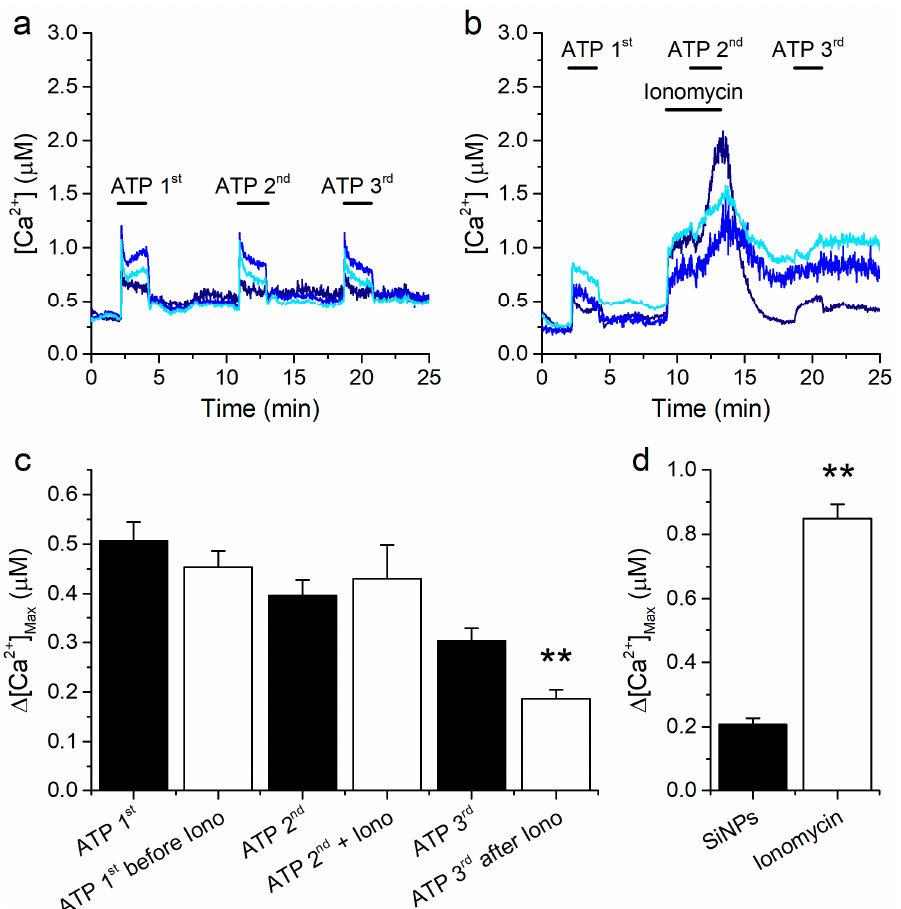
Figure 6. Response to ATP in 16HBE cells overloaded with Ca 2+ . ( a ) Example of control [Ca 2+ ] traces recorded in 16HBE cells showing the responses to repetitive extracellular application of 10 µ M ATP. ( b ) Examples of traces showing the effects of 1 μ M ionomycin when applied before and during the second application of 10 μ M ATP. ( c ) Amplitude of the responses to three consecutive applications of ATP for the control series of experiments (black bars, n = 36) and for a series of experiments in which 1 μ M ionomycin was applied 2 min before and during the second application of ATP (white bars, n = 42). The data are represented as mean ± s.e.m. The asterisks denote statistically significant difference between ATP 3rd and ATP 3rd after ionomycin ( p < 0.01; Kolmogorov–Smirnov test). ( d ) Comparison of the amplitude of the [Ca 2+ ] responses induced by 100 μ g/mL SiNPs and by 1 μ M ionomycin ( n = 92 and 42, respectively). The data are represented as mean ± s.e.m. The asterisks (**) denote statistically significant difference between the two bars ( p < 0.01; Kolmogorov–Smirnov test). As expected, ionomycin induced a fast and robust increase in [Ca 2+ ], which was in